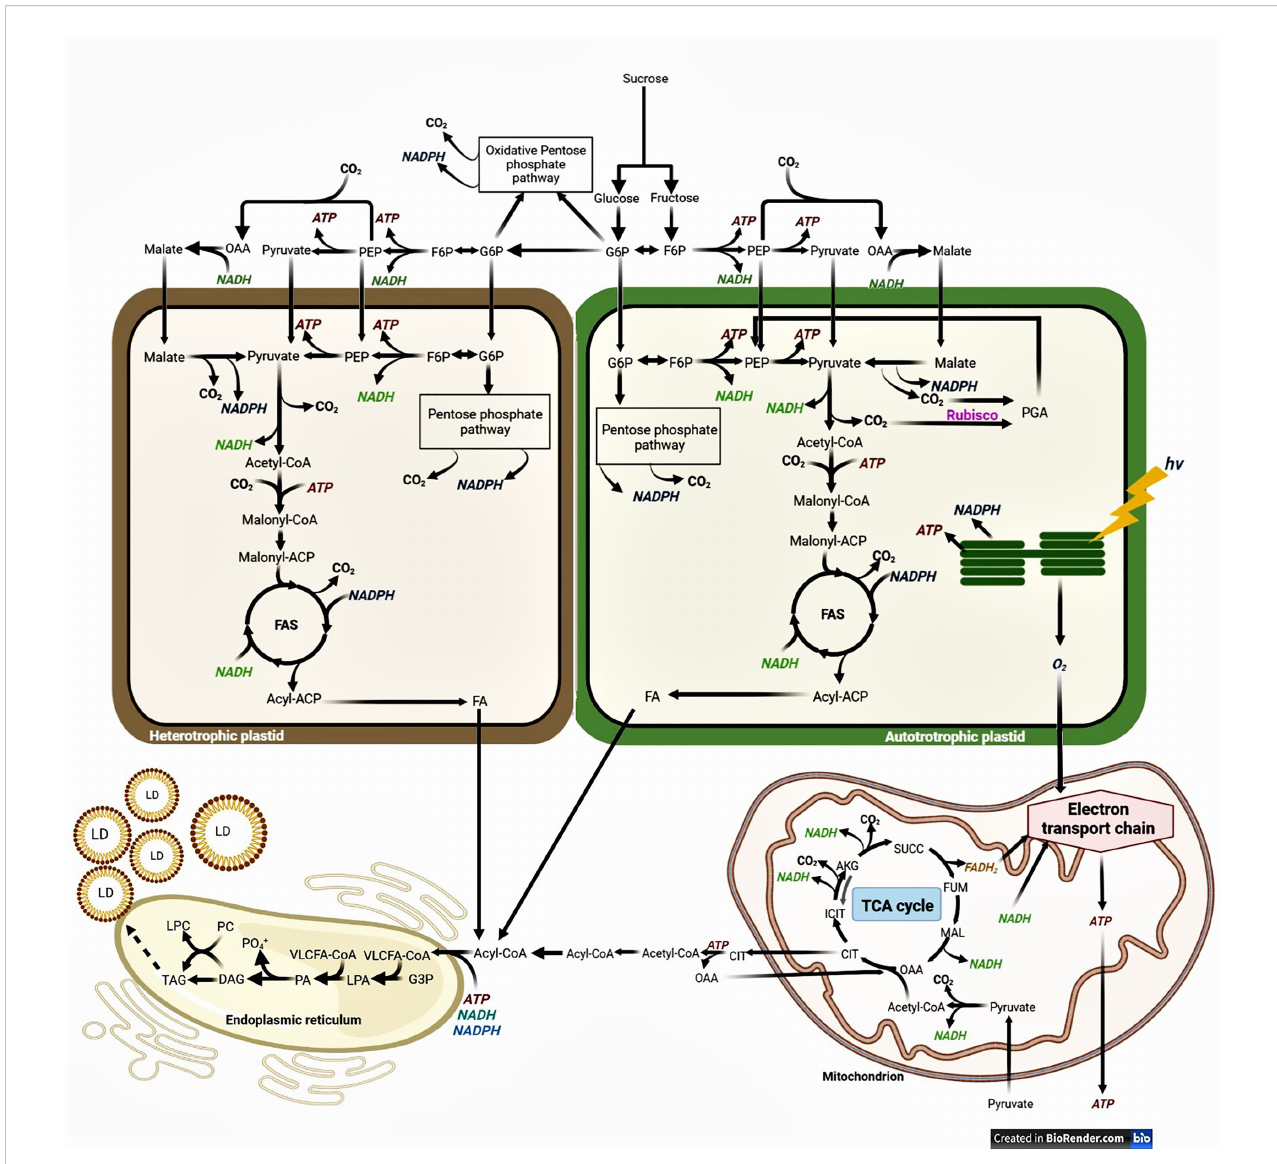
FIGURE 1 Simpli fi ed schematic biochemical pathway of fatty acid and TG synthesis in higher plants. Fatty acid synthesis (FAS) and lipid droplet (LD) formation in heterotrophic and in autotrophic embryos. ACP, acyl carrier protein; AKG, a -ketoglutarate; CIT, citrate; CoA, coenzyme A; DAG, diacylglycerol; FA, fatty acid; F6P, fructose 6-phosphate; FUM, fumarate; G6P, glucose 6-phosphate; hv , light; ICIT, isocitrate; LD, lipid droplet; LPA, lysophosphatidic acid; LPC, lysophosphatidylcholine; MAL, malate; OAA, oxaloacetate; PA, phosphatidic acid; PC, phosphatidylcholine; PGA, phosphoglycerate; PEP, phosphoenolpyruvate; PGA, phosphoglycerate; SUCC, succinate; TCA, tricarboxylic acid; TG, triacylglycerol; VLCFA, very-long-chain fatty